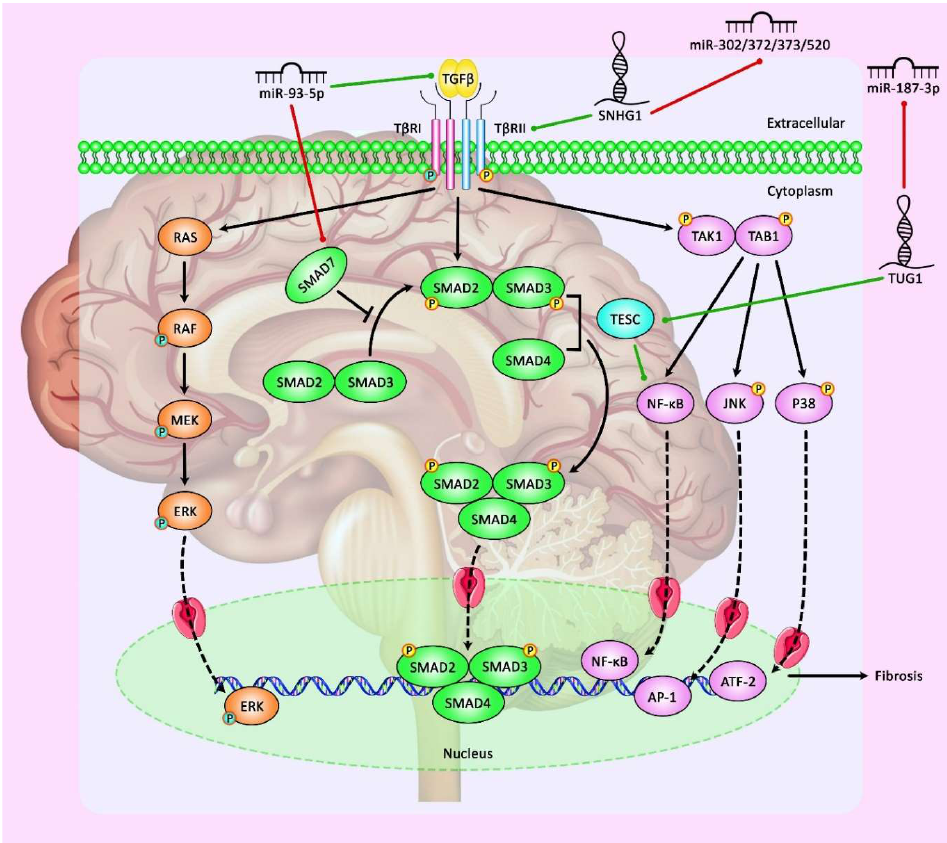
Figure 2. A schematic diagram of the role of various ncRNAs in modulating the TGF- β /SMAD signaling pathway in pituitary gland tumors. According to this cascade, it could be triggered through the binding of active TGF- β with T β RII and forming the T β RI-T β RII heteromeric complex, resulting in phosphorylation of Smad2/3, oligomerization with Smad4, and consequent nuclear translocation to modulate the transcription of ECM genes. Furthermore, Smad7 could play a remarkable role as a negative modulator of the TGF- β cascade. In addition, TGF- β has a significant part in triggering the activation of downstream signaling pathways containing MAPK, modulated by the Ras-Raf-MEK-ERK cascade, and TAK1, regulated by the TAB1 pathway. This could also lead to mediating the activation of MKK4-JNK and MKK3-p38 cascades and upregulation of AP-1 and ATF-2, respectively, and the overexpression of NF- κ B to modulate profibrotic responses [61]. Previous studies have authenticated that several ncRNAs could have a significant part in regulating the TGF- β /SMAD cascade in pituitary gland tumors. As an illustration, recent literature has detected that overexpression of lnc-SNHG1 could considerably elevate the expression level of T β RII through activating T β RII/SMAD3 in invasive pituitary tumor cells via sponging miR-302/372/373/520 [31]. Furthermore, other research has indicated that upregulation of miR-93-5p could downregulate the expression level of Smad7, thereby activating the TGF- β 1/Smad3 signaling-mediated fibrosis of prolactinoma cells [51]. Green arrows indicate the upregulation of target genes modulated via ncRNAs (miRNAs and lncRNAs); red arrows depict inhibition regulated by